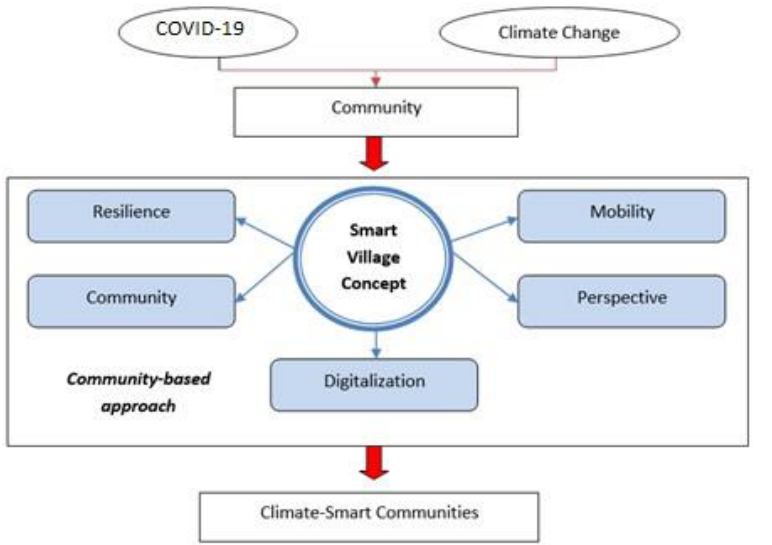
Figure 1. Conceptual Understanding of Community-Based Approach for Smart Village (source au-